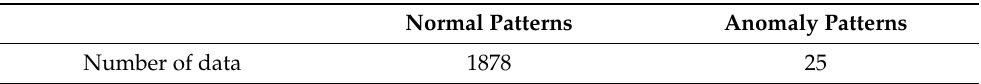
Table 3. The number of engine clutch engagement/disengagement patterns for model training and test (after the copy of anomaly patterns).